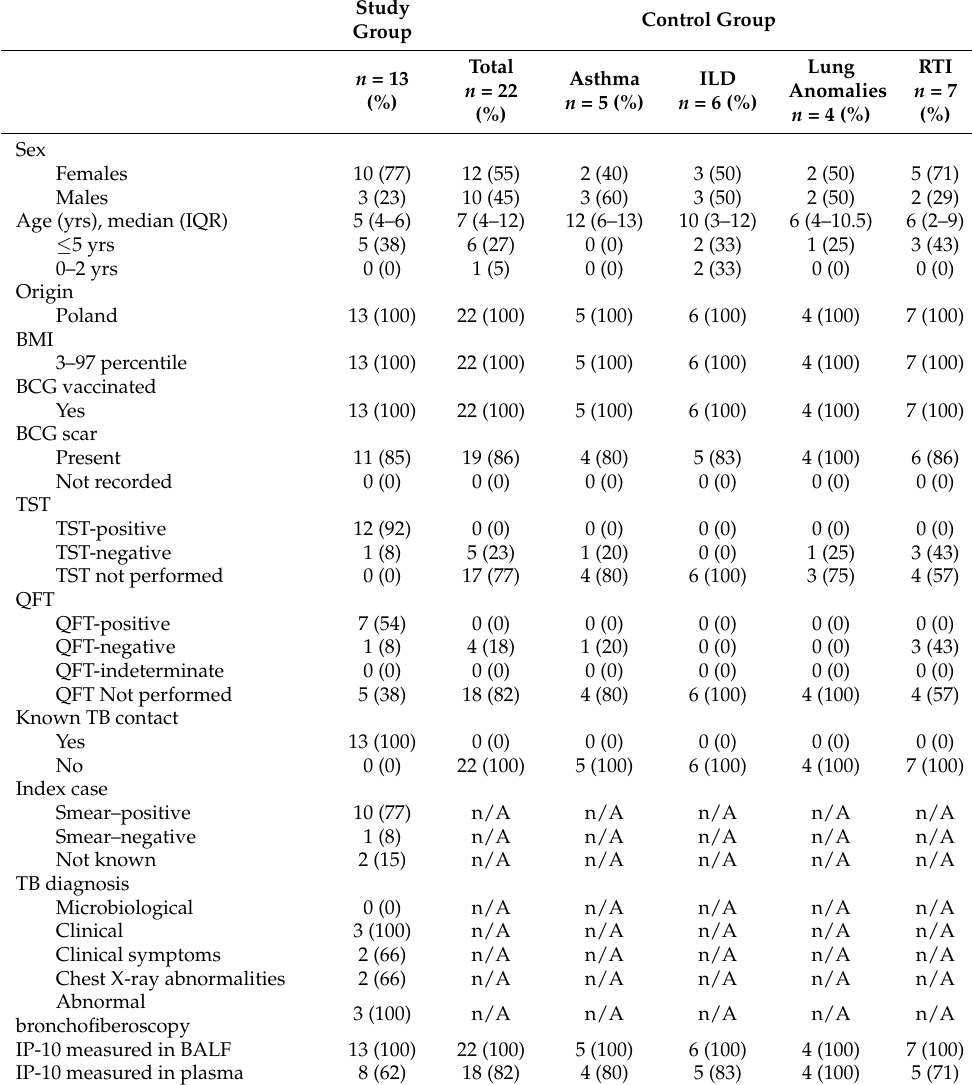
Table 1. Characteristics of the study participants.